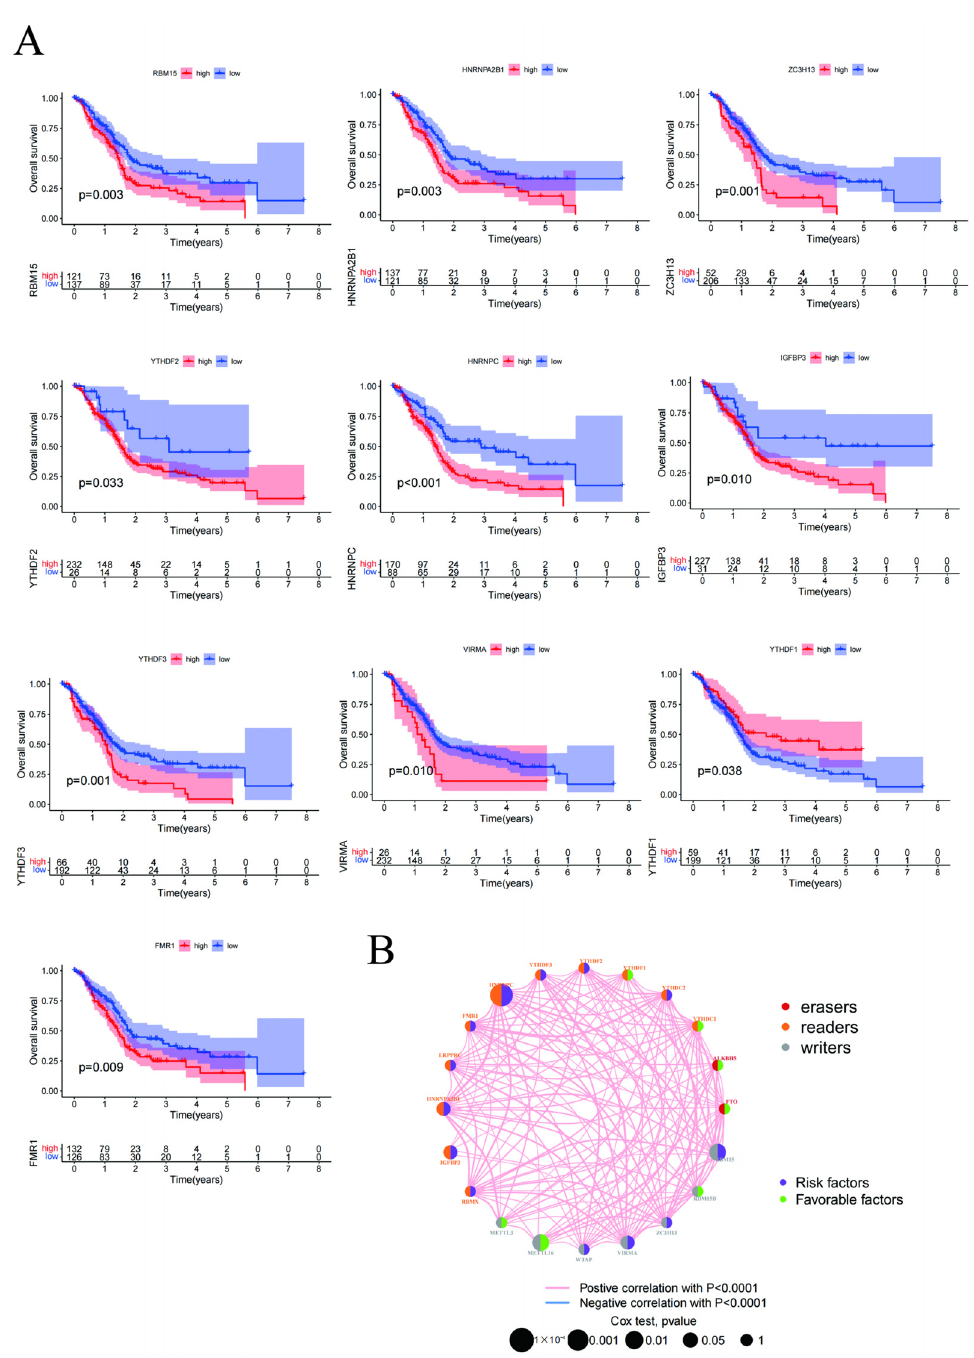
Figure 2. ( A ) Gene expression with survival analysis; ( B ) Analysis of the constructed prognostic network diagram.